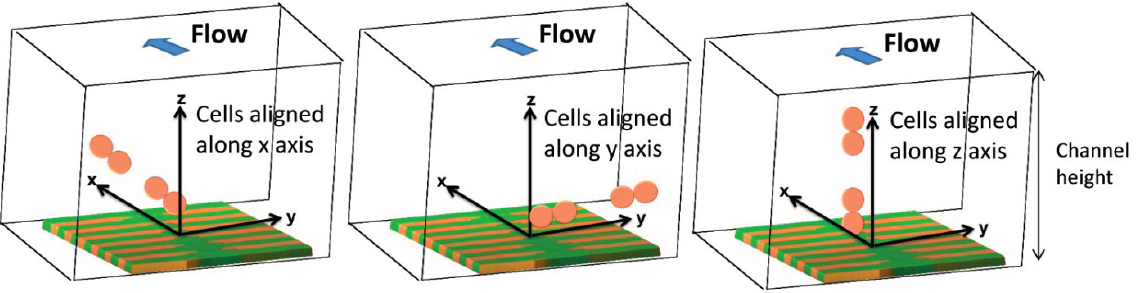
Figure 14. Schematics of cell orientations along x , y and z axis considered for cells in flow ( x axis direction) in Wolfram Mathematica 7.0 simulations.